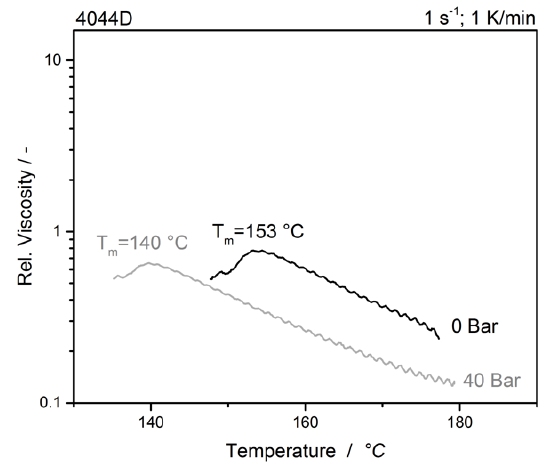
Figure 7. Crystallization of the unmodified sample at two different pressures .